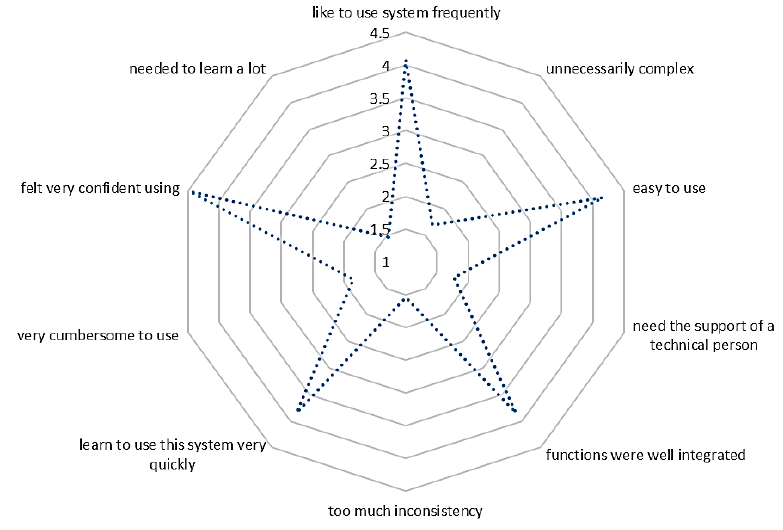
Figure 23. Individual results of the System Usability Scale (SUS) questionnaire.